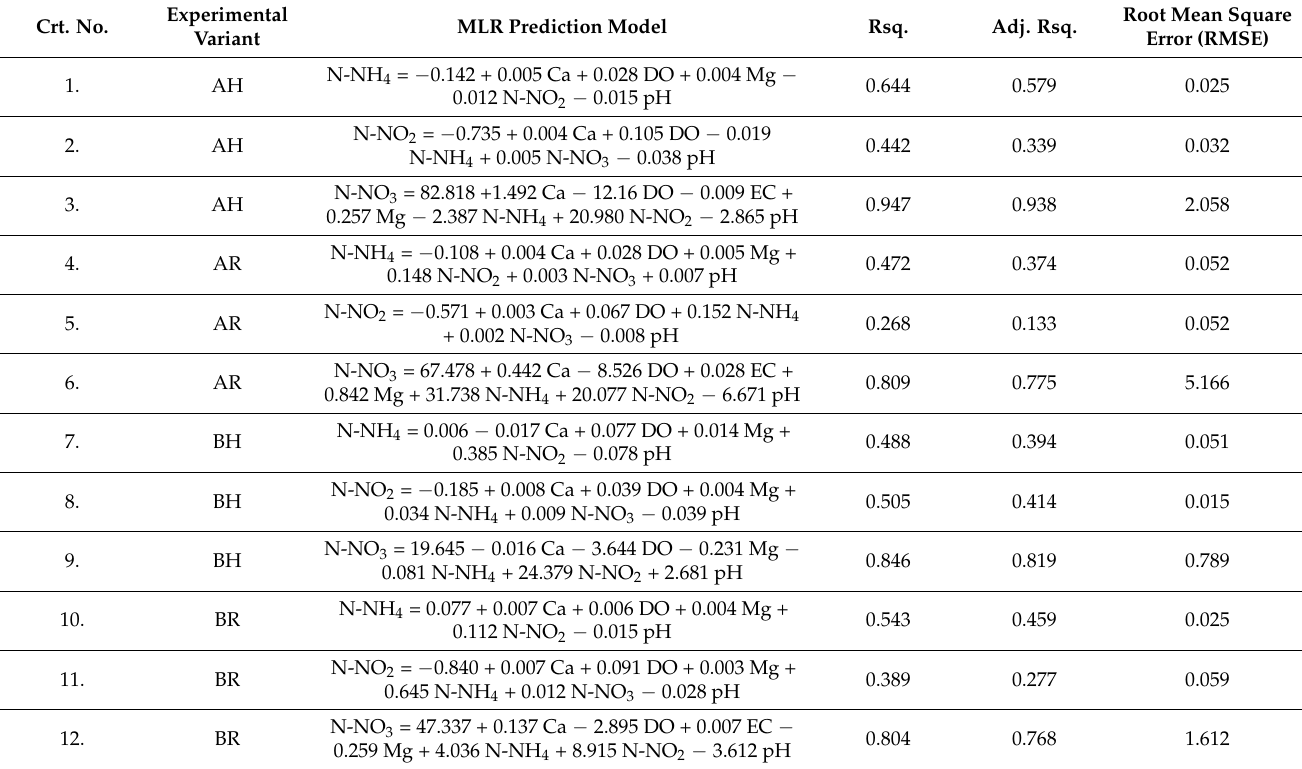
Table 6. The MLR models for predicting nitrogen compounds concentration in technological water, for each of the experimental